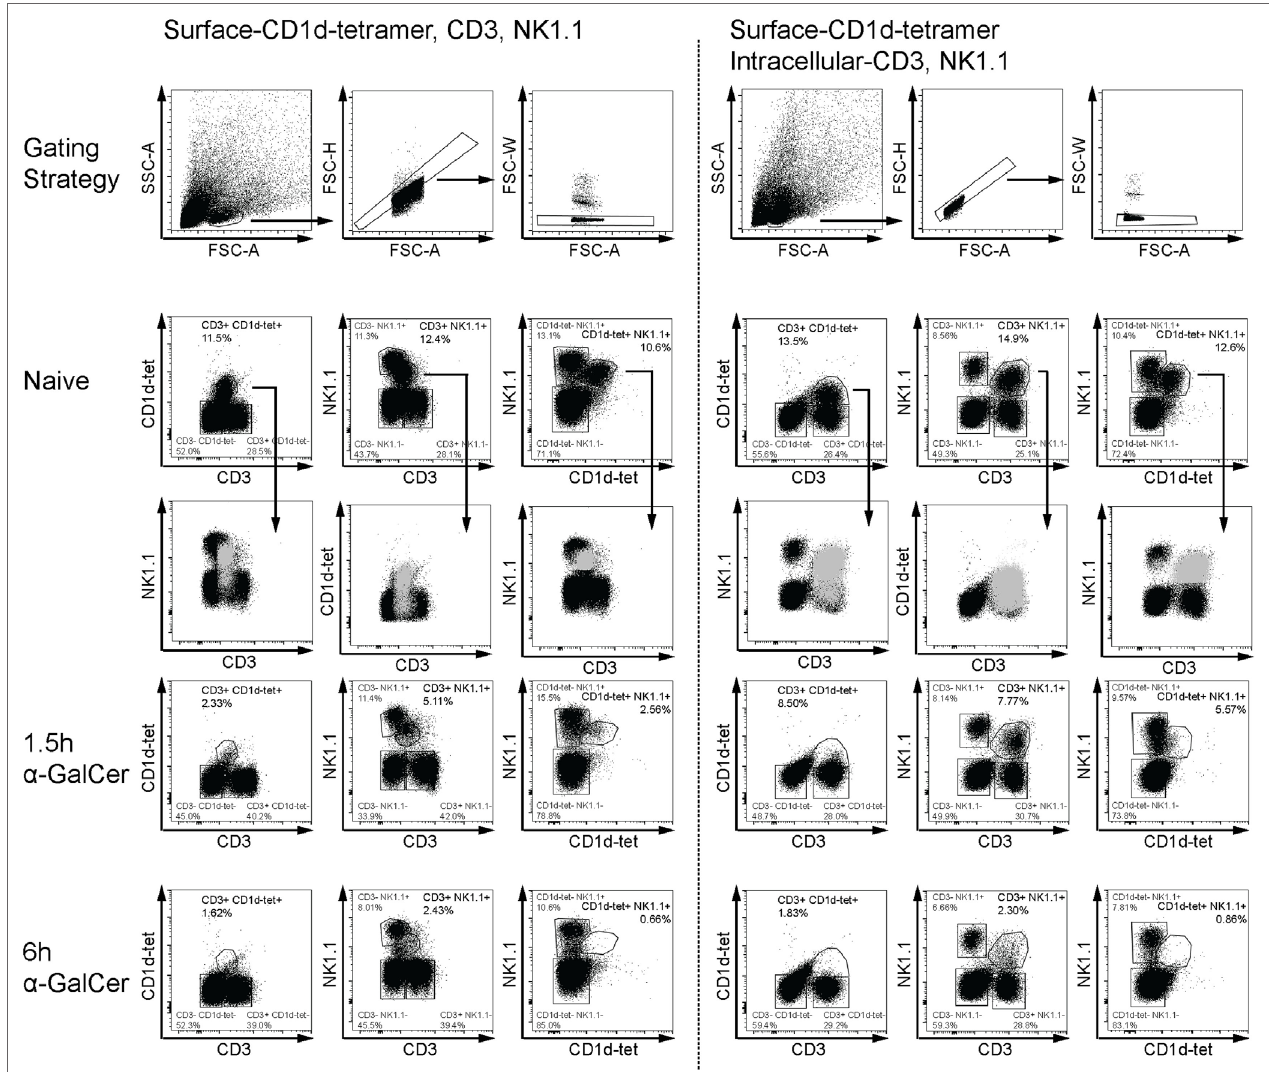
FigUre 1 | Flow cytometry-based detection of liver natural killer T (NKT) cells. Liver leukocytes from naïve or α -GalCer-challenged mice were stained with surface CD1d tetramer (CD1d-tet). Half of the liver sample was stained for surface expression of CD3 and NK1.1 (left panel), while the other half was permeabilized for intracellular expression of CD3 and NK1.1 (right panel). Various gating strategies for CD3, NK1.1, and CD1d-tet expression over time are shown as a comparison of surface and intracellular expression. Putative “NKT” cells from naïve mice (light gray) have been overlayed to show placement within dot plots using the third marker. Surface expression of all three markers are reduced as early as 1.5 h after α -galactosylceramide ( α -GalCer) challenge (left panel); however, intracellular CD3 and NK1.1 expression is sustained at this early time point (right panel). Data are representative of three mice per time